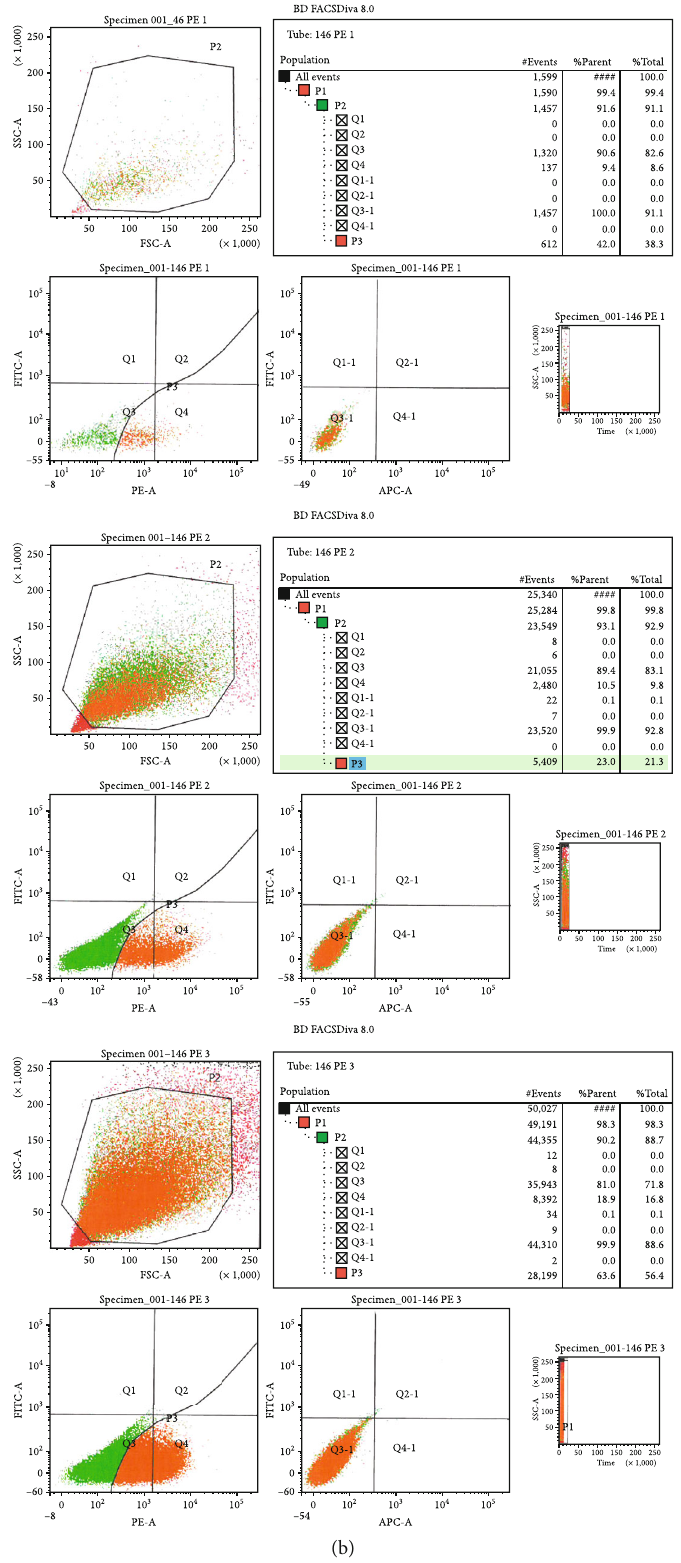
Figure 5: (a) The CD271 fl ow cytometry graphs of 3 cell lines of the heterogeneous GMSC population, signal percentage of cell line A: 2% (upper), cell line B: 1% (middle), and cell line C: 4% (lower). (b) The CD146 fl ow cytometry graphs of 3 cell lines of the heterogeneous GMSC population, signal percentage of cell line A: 10% (upper), cell line B: 11% (middle), and cell line C: 17%